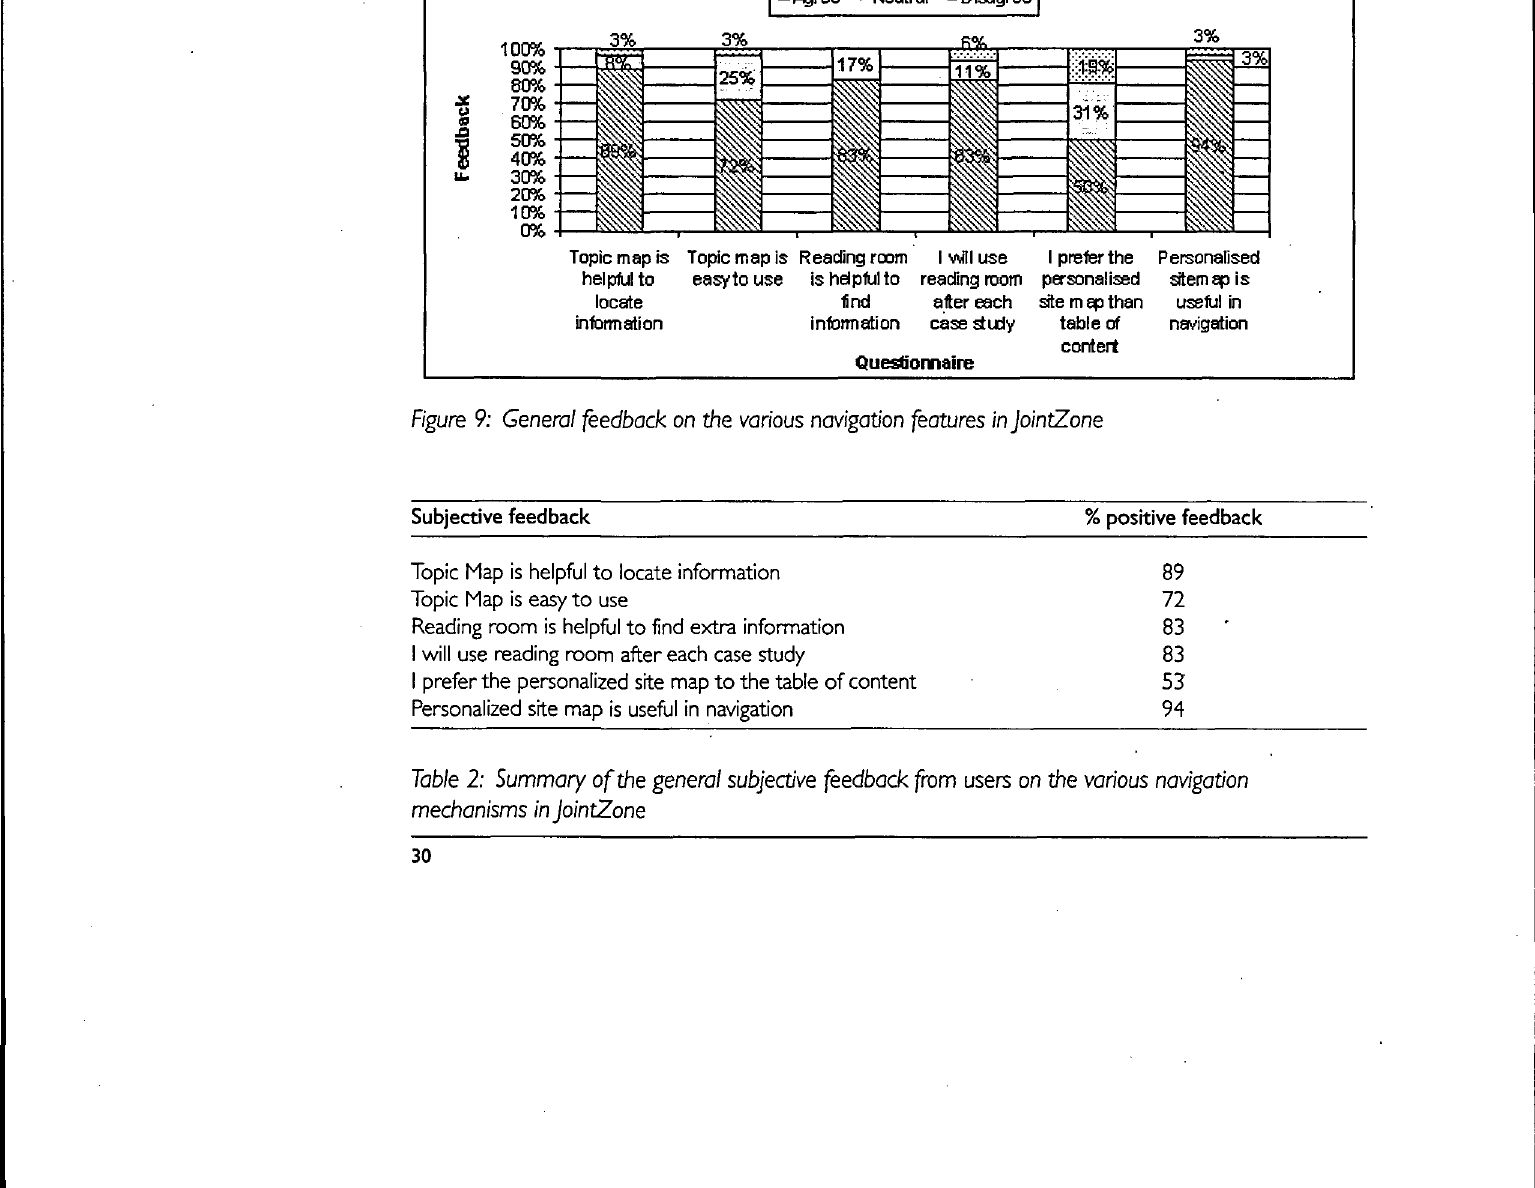
Table 2: Summary of the general subjective feedback from users on the various navigation mechanisms in